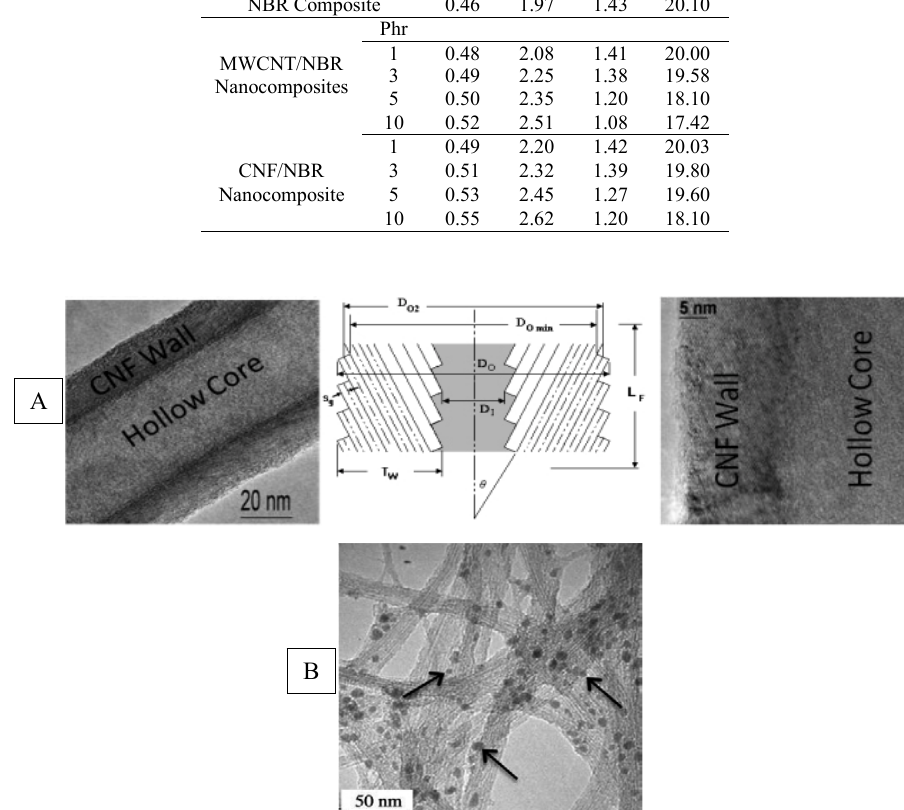
Fig. 1. HRTEM images of CNFs and MWCNTs (A and B,